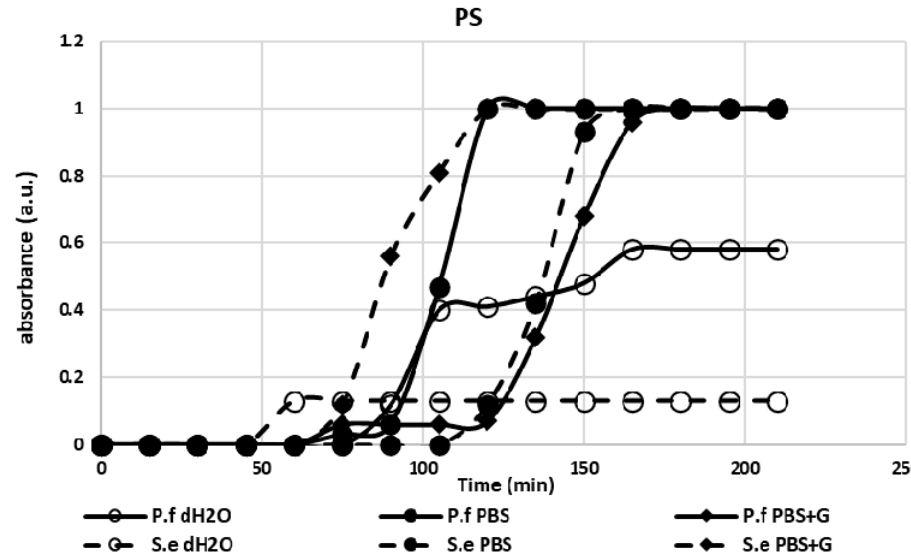
Figure 4. Evolution of polysaccharide (PS) intensity band over the time.